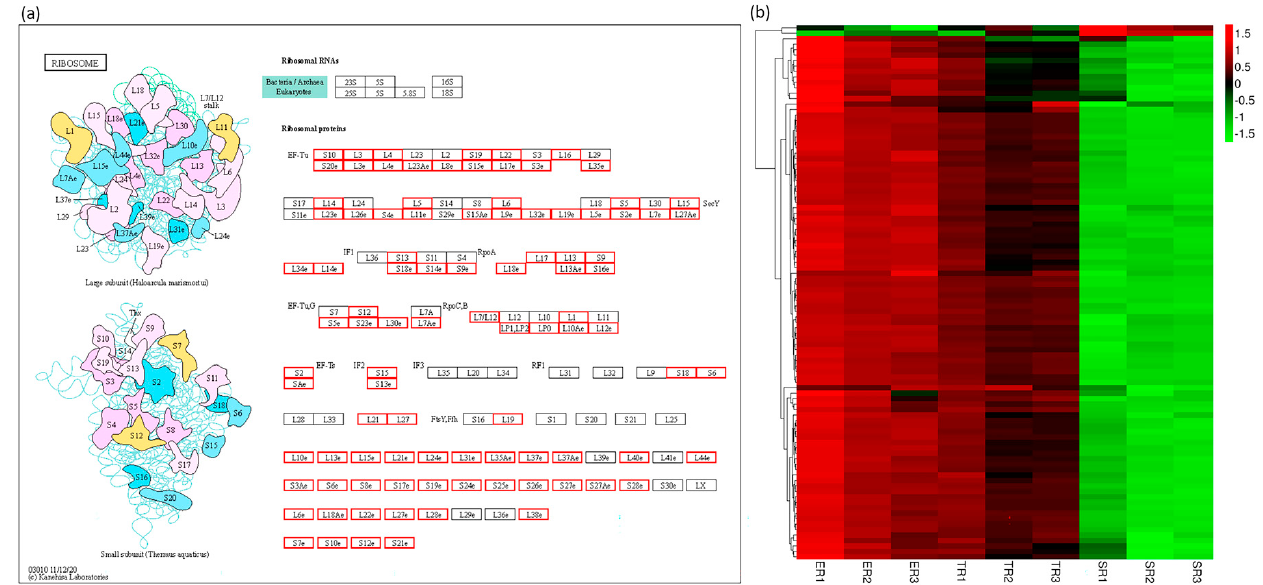
Figure 9. Differentially expressed genes of ribosome pathway. ( a ) Putative ribosome pathway in F. filiformis generated by KEGG analysis. Boxes with a black border mean no genes were annotated, boxes with a red border mean at least one gene was annotated. ( b ) Heat map showing expression profiles of ribosome genes. Gene expression values (FPKM) were transformed to Z-score